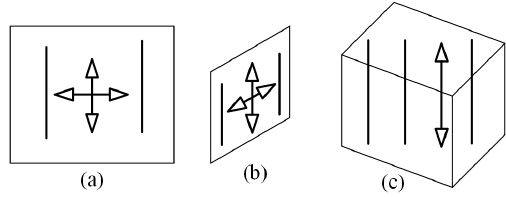
Figure 1. (a) Freedom space of the moving platform. (b) Constraint space of the moving platform.